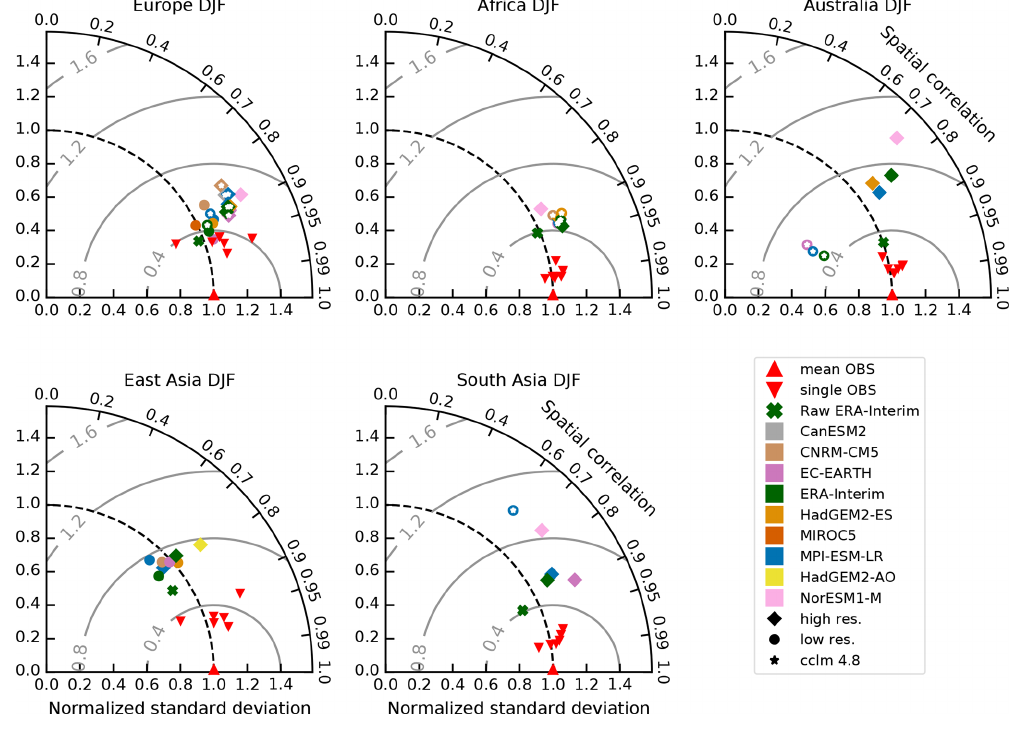
Figure 7. Same as Fig. 5 but for precipitation, without the zoomed results.